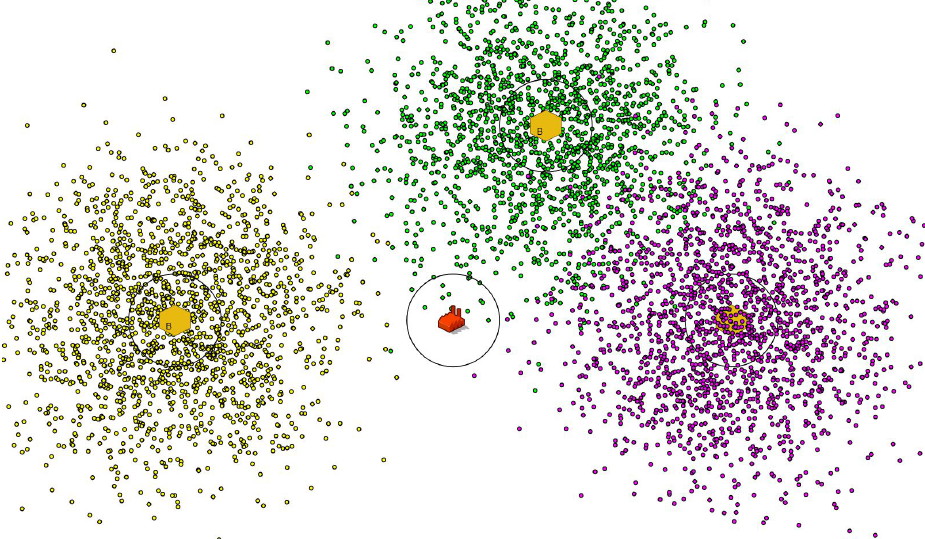
Figure 2. Biological communication system. Three nodes send signaling molecules to the BS (at the